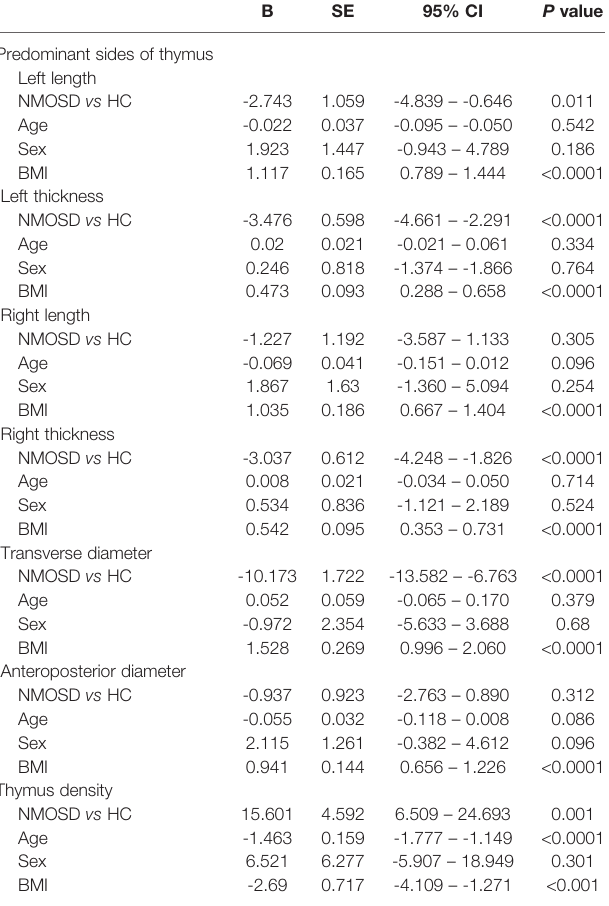
TABLE 4 | Linear regressions analysis between multiple variables and thymus